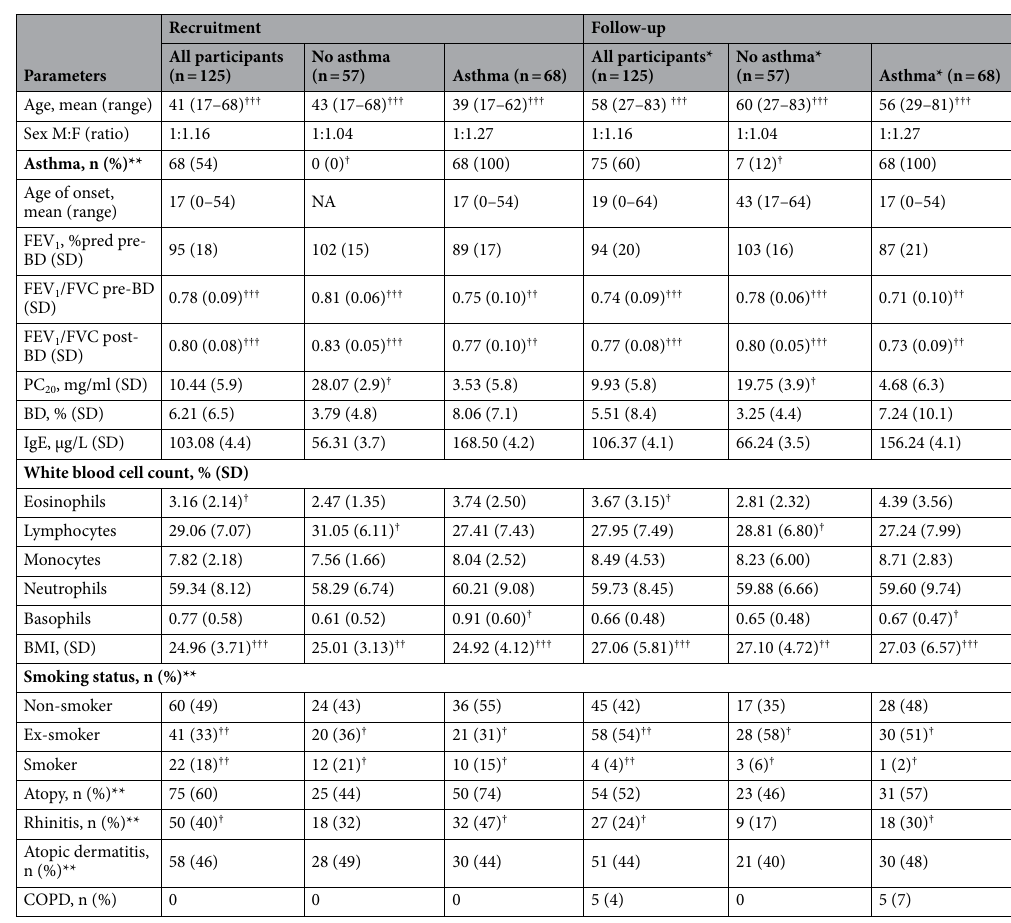
Table 1. Characteristics of the 125 individuals at recruitment and follow-up. Data is shown as mean (SD), n (%) or in range. Statistics were performed for each group, i.e., the All participants, the No asthma, and the Asthma groups, between recruitment and follow-up, using T-test or Wilcoxon test for matched data or continuous variables or chi-square or Fisher exact test for categorical variables: †p < 0.05, ††p < 0.001 and †††p < 0.0001. BMI body mass index (kg/m 2 ), BD bronchodilator response, COPD chronic obstructive pulmonary disease, FEV 1 forced expiratory volume in 1 s, FVC forced vital capacity, IgE immunoglobulin E, NA not available, PC 20 provocative concentration for a 20% decrease in FEV 1 , SD standard deviation. *Same individuals as at recruitment. **Percentage calculated with available data only (does not include missing values).